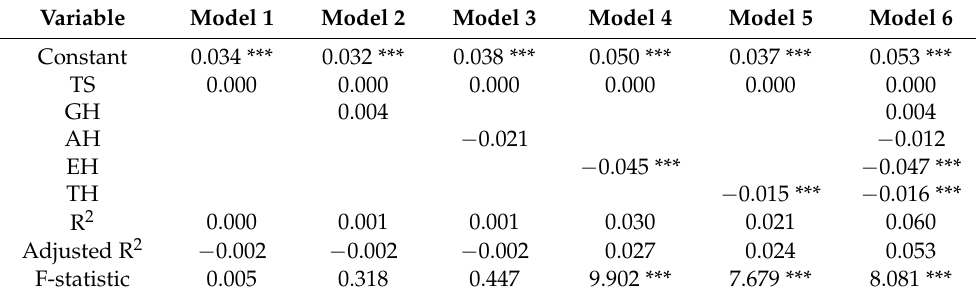
Table 4. Regression analysis